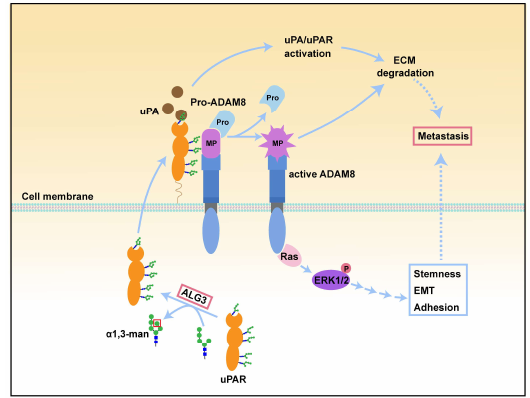
Figure 8. Schematic graph elucidating the underlying mechanisms through which uPAR α1,3-mannosylation catalyzed by ALG3 enhances uPA/uPAR activation and uPAR with ADAM8 interaction, which promotes ovarian cancer metastasis via the ADAM8/Ras/ERK pathway.